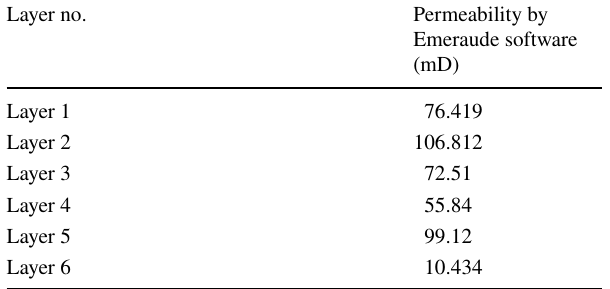
Table 7 Estimated flow rate from Emeraude software (bbl/D) Layers Estimated flow rate